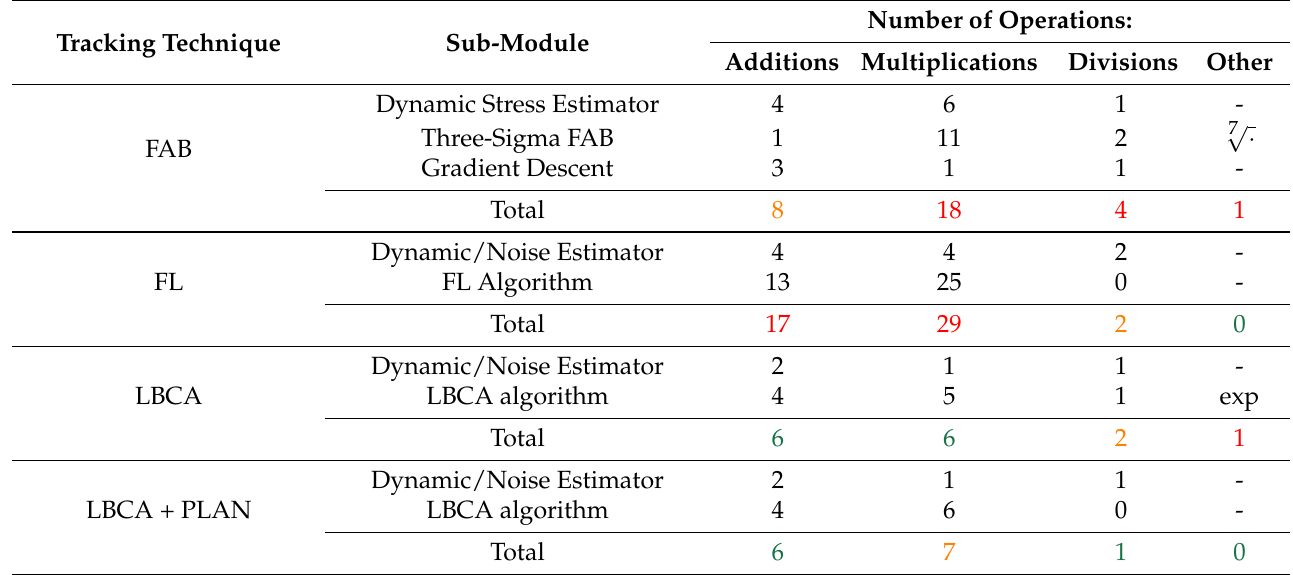
Table 2. Complexity of the adaptive loop-bandwidth tracking techniques based on the number of operations. Tracking